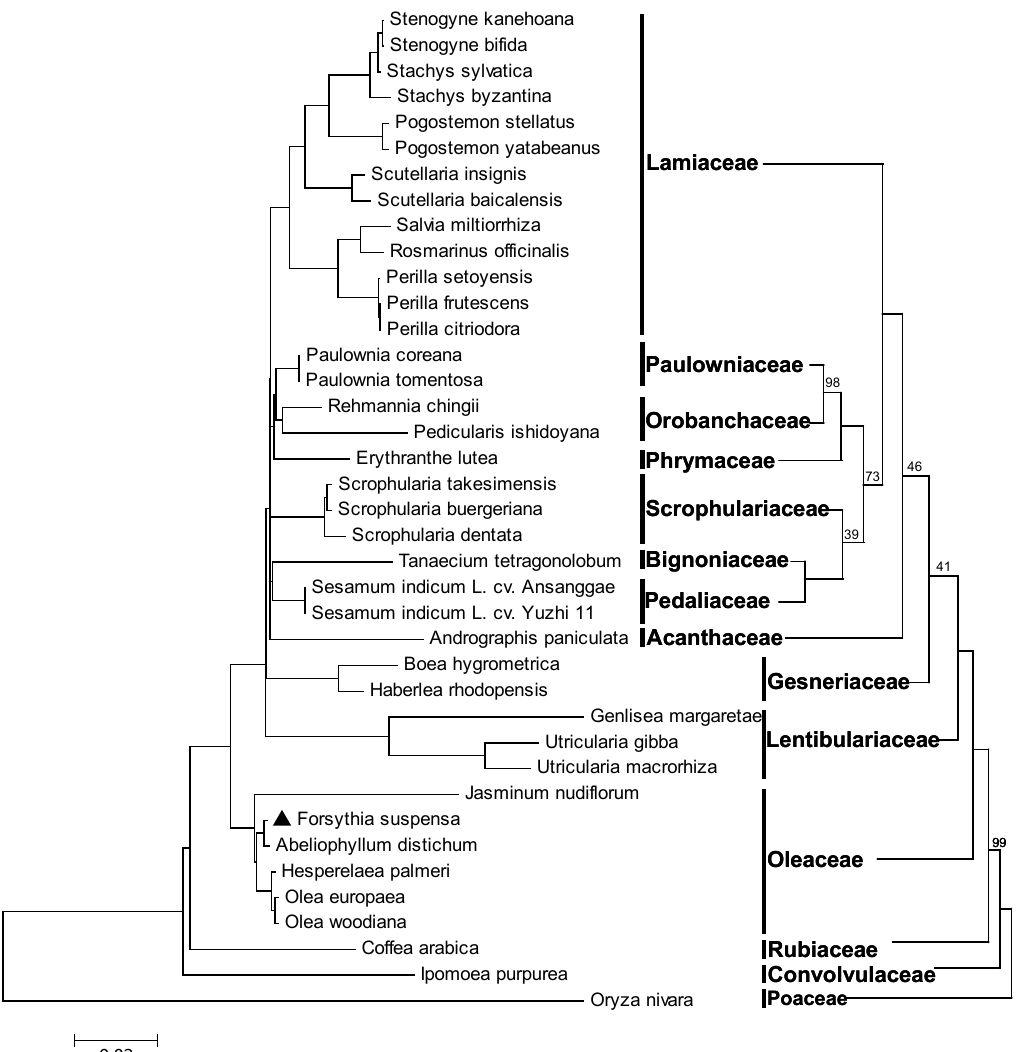
Figure 4. Maximum likelihood phylogeny of the Lamiales species inferred from complete chloroplast genome sequences. Numbers near branches are bootstrap values of 100 pseudo-replicates. The tree on the right panel was constructed manually by reference to the left one, and the distance of branches was meaningless. The branches without numbers indicate 100% bootstrap supports.